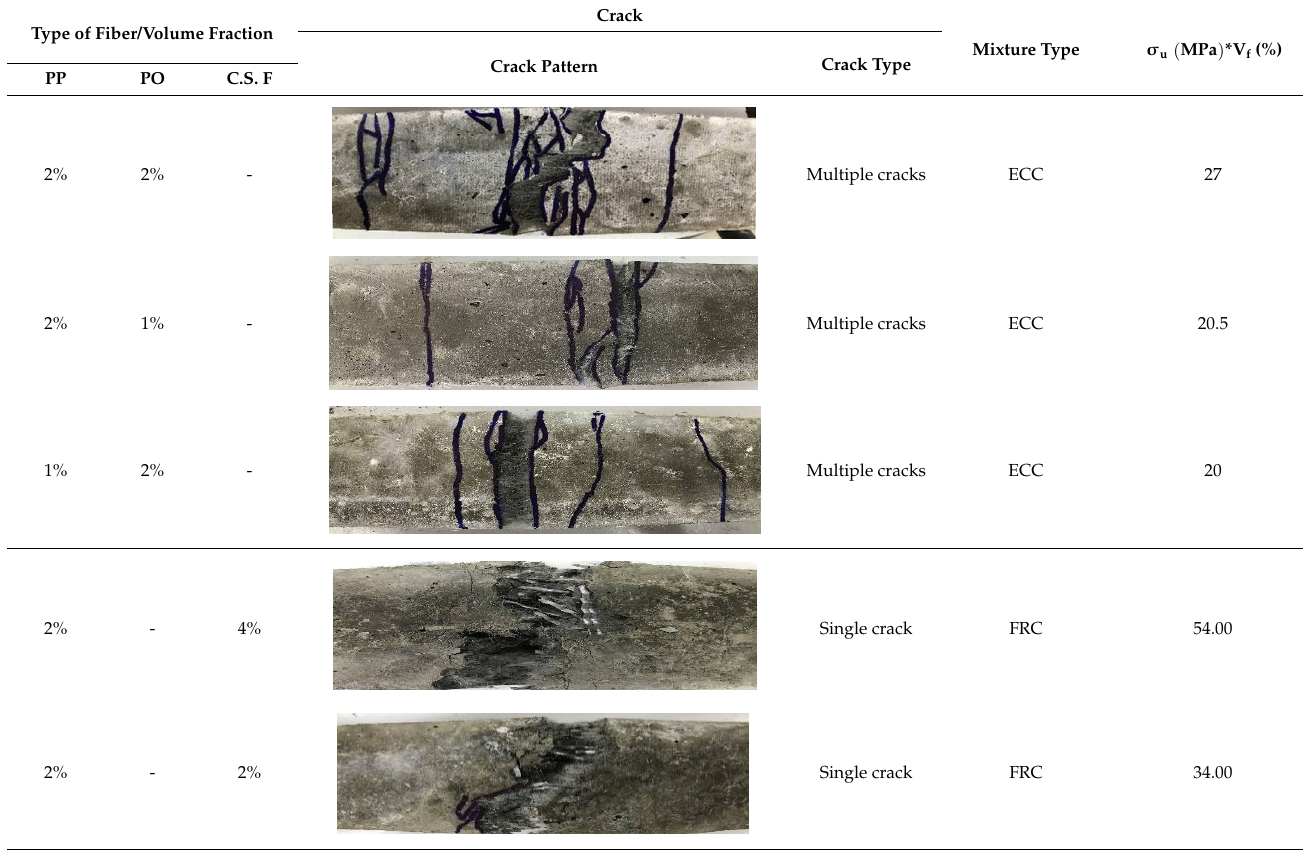
Table 5. ECC and FRC crack pattern of mixtures reinforced with hybrid fiber.